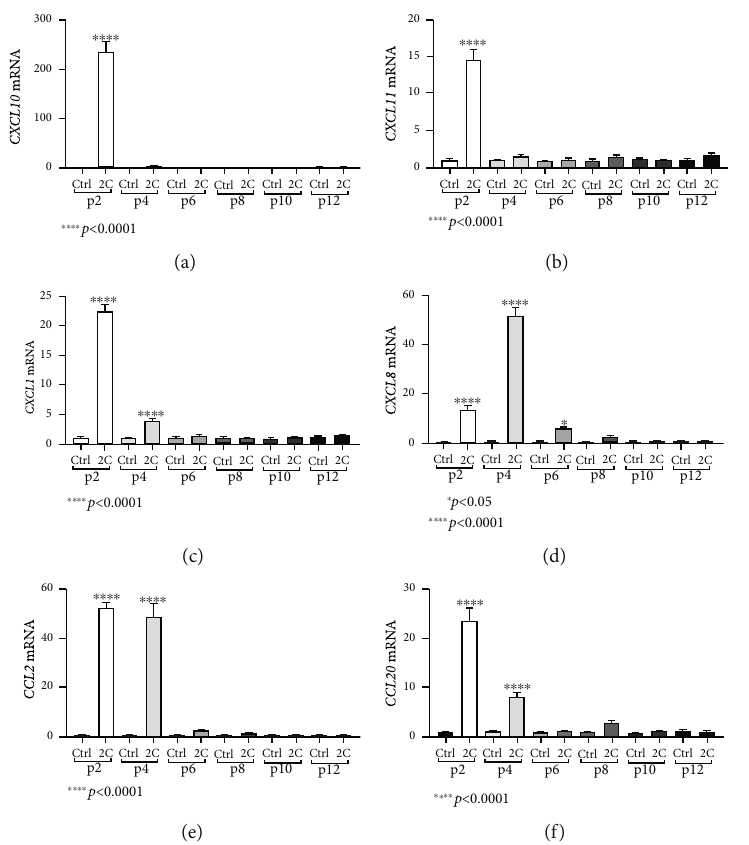
Figure 5: HIOs exhibit mesenchymal and epithelial chemokine mRNA responses to in fl ammatory cytokines. IL-1 α and TNF- α (2C) induced the mRNA expression of CXCL10 in passage 2 (a), CXCL11 in passage 2 (b), CXCL1 in passages 2 and 4 (c), CXCL8 in passages 2, 4, and 6 (d), CCL2 in passages 2 and 4 (e), and CCL20 in passages 2 and 4 (f). Concentrations of cytokines used: IL-1 α 5ng/ml, TNF- α 50ng/ml. All experiments were performed in triplicate. The gene expression of each studied gene was normalized against GAPDH gene expression in the same sample using the 2 - ΔΔ Ct method. In every passage, expression levels of treated organoids were normalized against those of the control ones. Data are presented as the mean ± standard errorof the mean ð SEM Þ